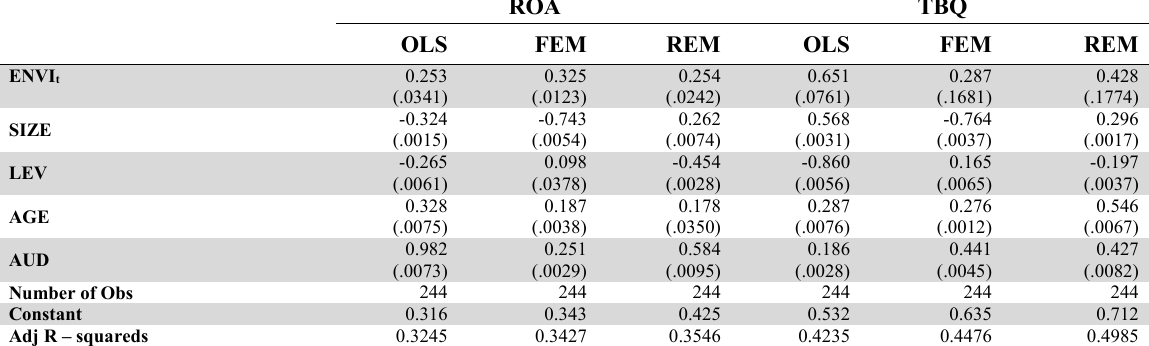
Regression Results - the case does not consider latency factor ROA